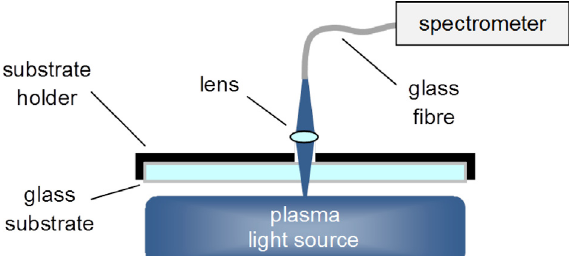
Fig. 1. Experimental setup. PECVD process including an op- tical port on the backside of the substrate carrier for trans- mission measurements. The plasma emission is used as light source.